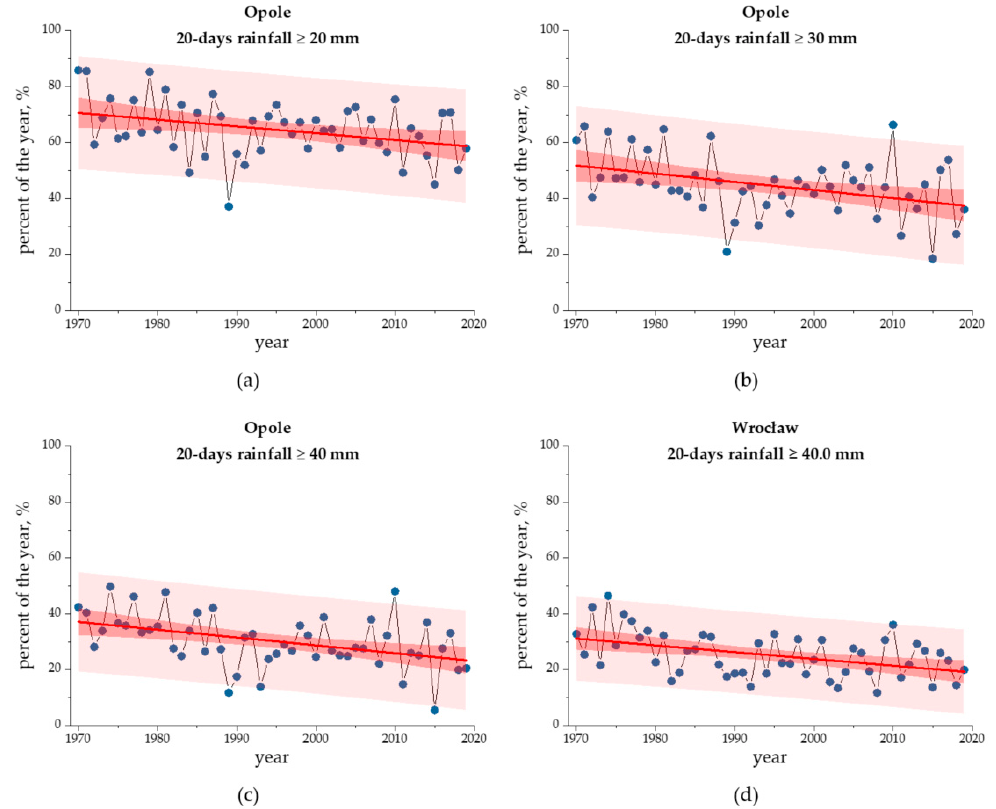
Figure 7. Statistically significant trends of changes in the sum of twenty-day rainfall in the years 1970–2019 in Opole ( a ) ≥ 20 mm, ( b ) ≥ 30 mm, ( c ) ≥ 40 mm and Wrocław ( d ) ≥ 40 mm.